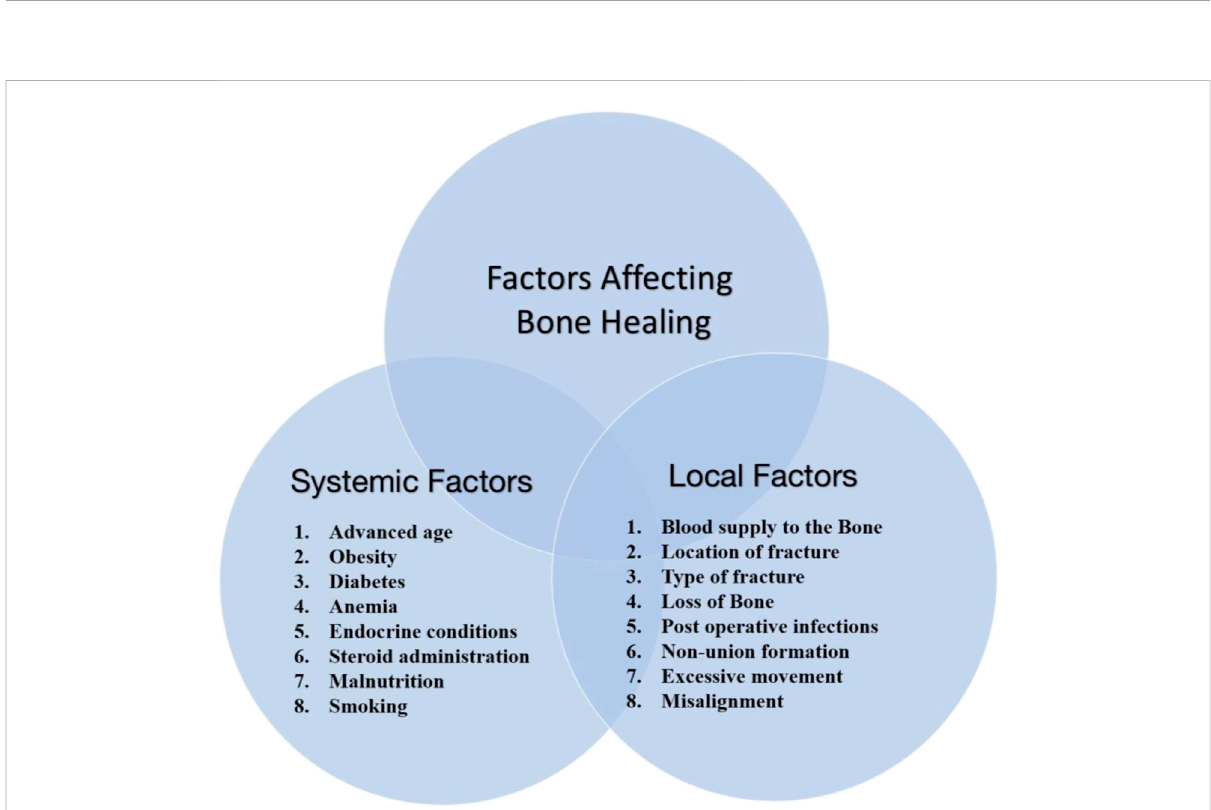
FIGURE 2 Factors responsible for fracture healing, including local and systemic